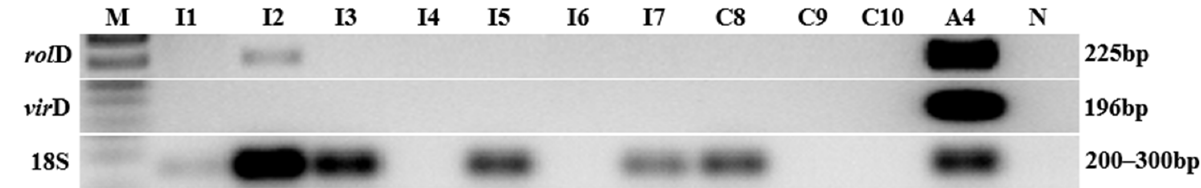
Figure 8. Seedlings inoculated by the liquid co-culture in vitro method after 28 days of inoculation. ( A ) Inoculated seedling. ( B ) Control seedling. Bars = 1.0 cm.